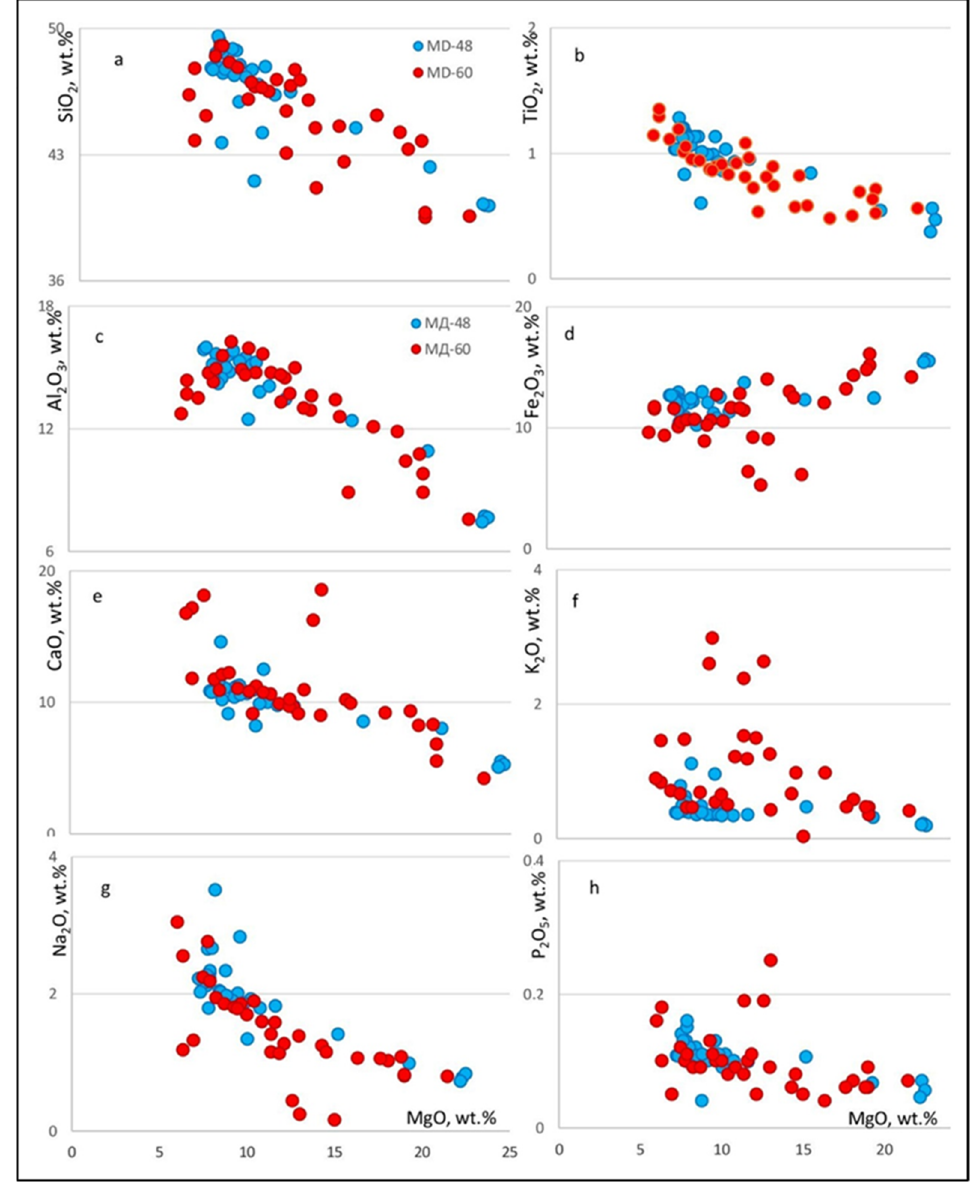
Figure 6. Variation diagrams MgO vs. SiO 2 ( a ), TiO 2 ( b ), CaO ( c ), Na 2 O ( d ), K 2 O ( e ), P 2 O 5 ( f ) for the rocks from the ( g ) MD-48 MgO and ( h ) MD-60 MgO boreholes.